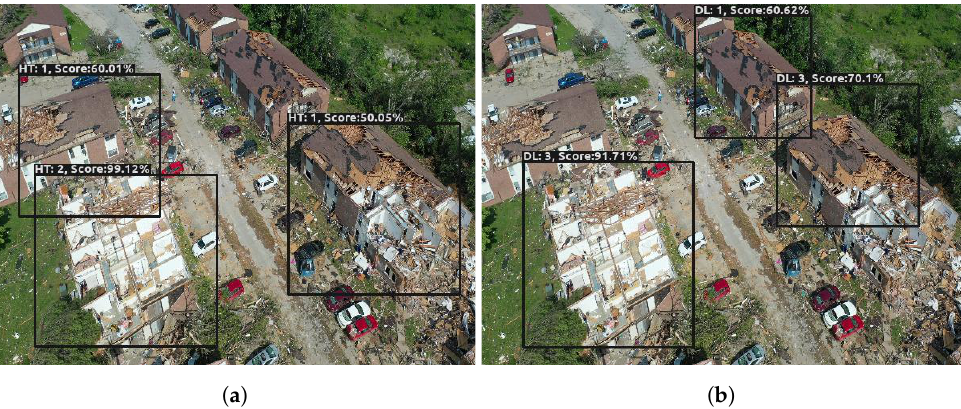
Figure 11. UAV image prediction: ( a ) hazard-type classification by M HT ( FRC , RN ) ; ( b ) damage-level classification by M DL ( FRC , RN )